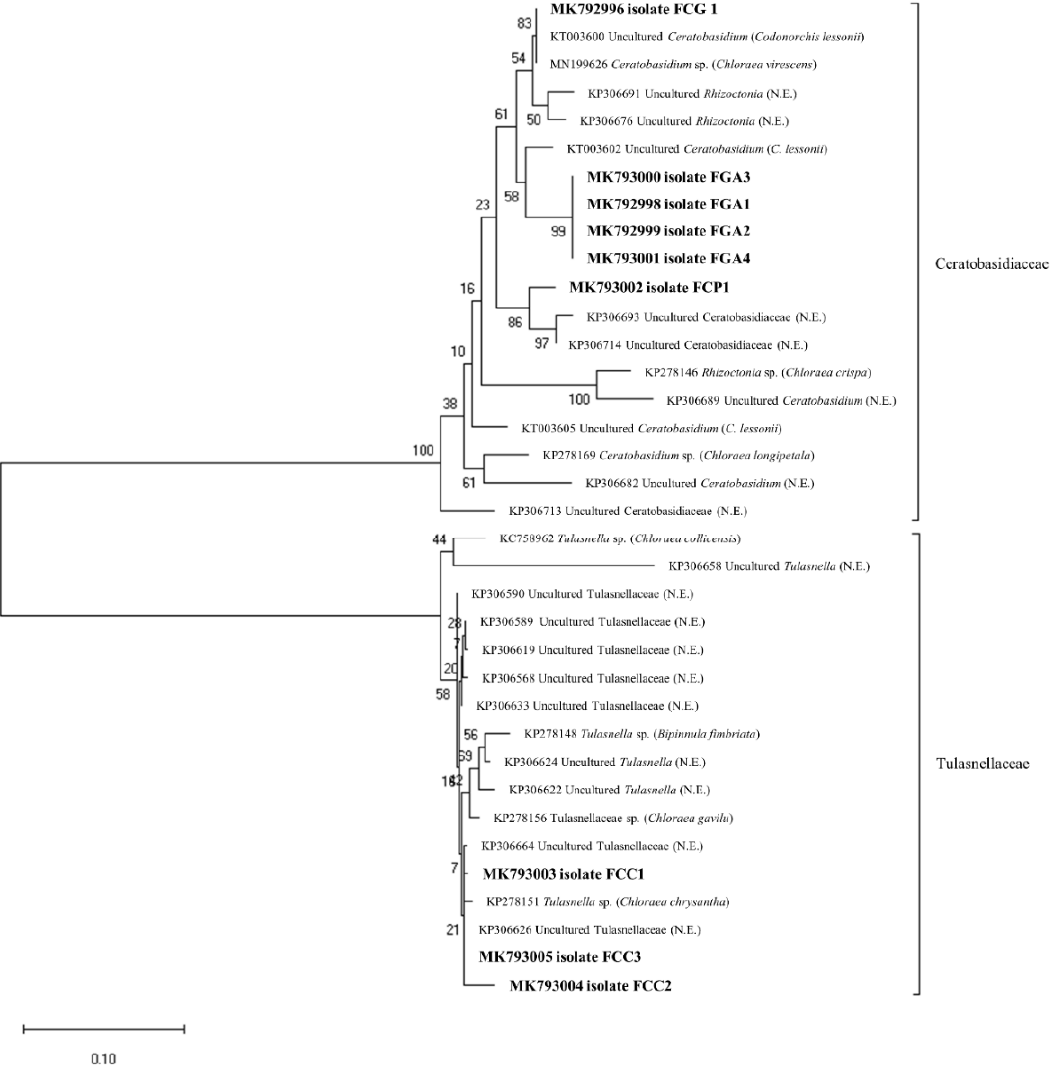
Figure 2. Maximum likelihood tree of ITS sequences of orchid mycorrhizal fungi isolated from orchid from Araucanía Region, Southern Chile (in bold). The tree also includes mycorrhizal fungi isolated from other Chilean native orchids.